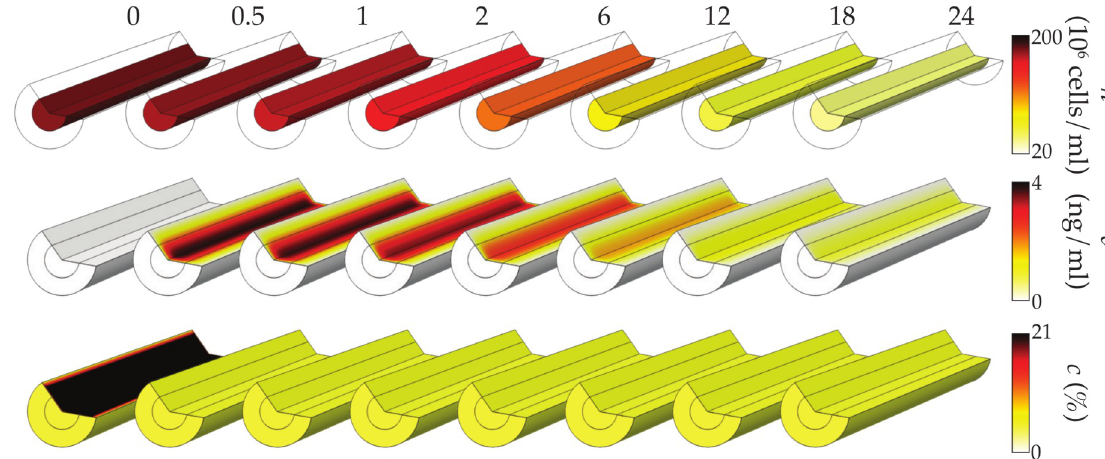
Fig 6. Cell-solute interactions in a permeable nerve repair construct results in a quick decrease in oxygen concentration and a low uniform VEGF concentration. Heatmaps of cell density, oxygen and VEGF concentration over 24 hours for an initial cell density n 0 = 1.78 × 10 6 cells/ml and a porosity � = 0.8. The porous sheath structure is approximated by an array of overlapping spheres (see Table 1) with a thickness T = 0.25mm and a porosity � = 0.8.